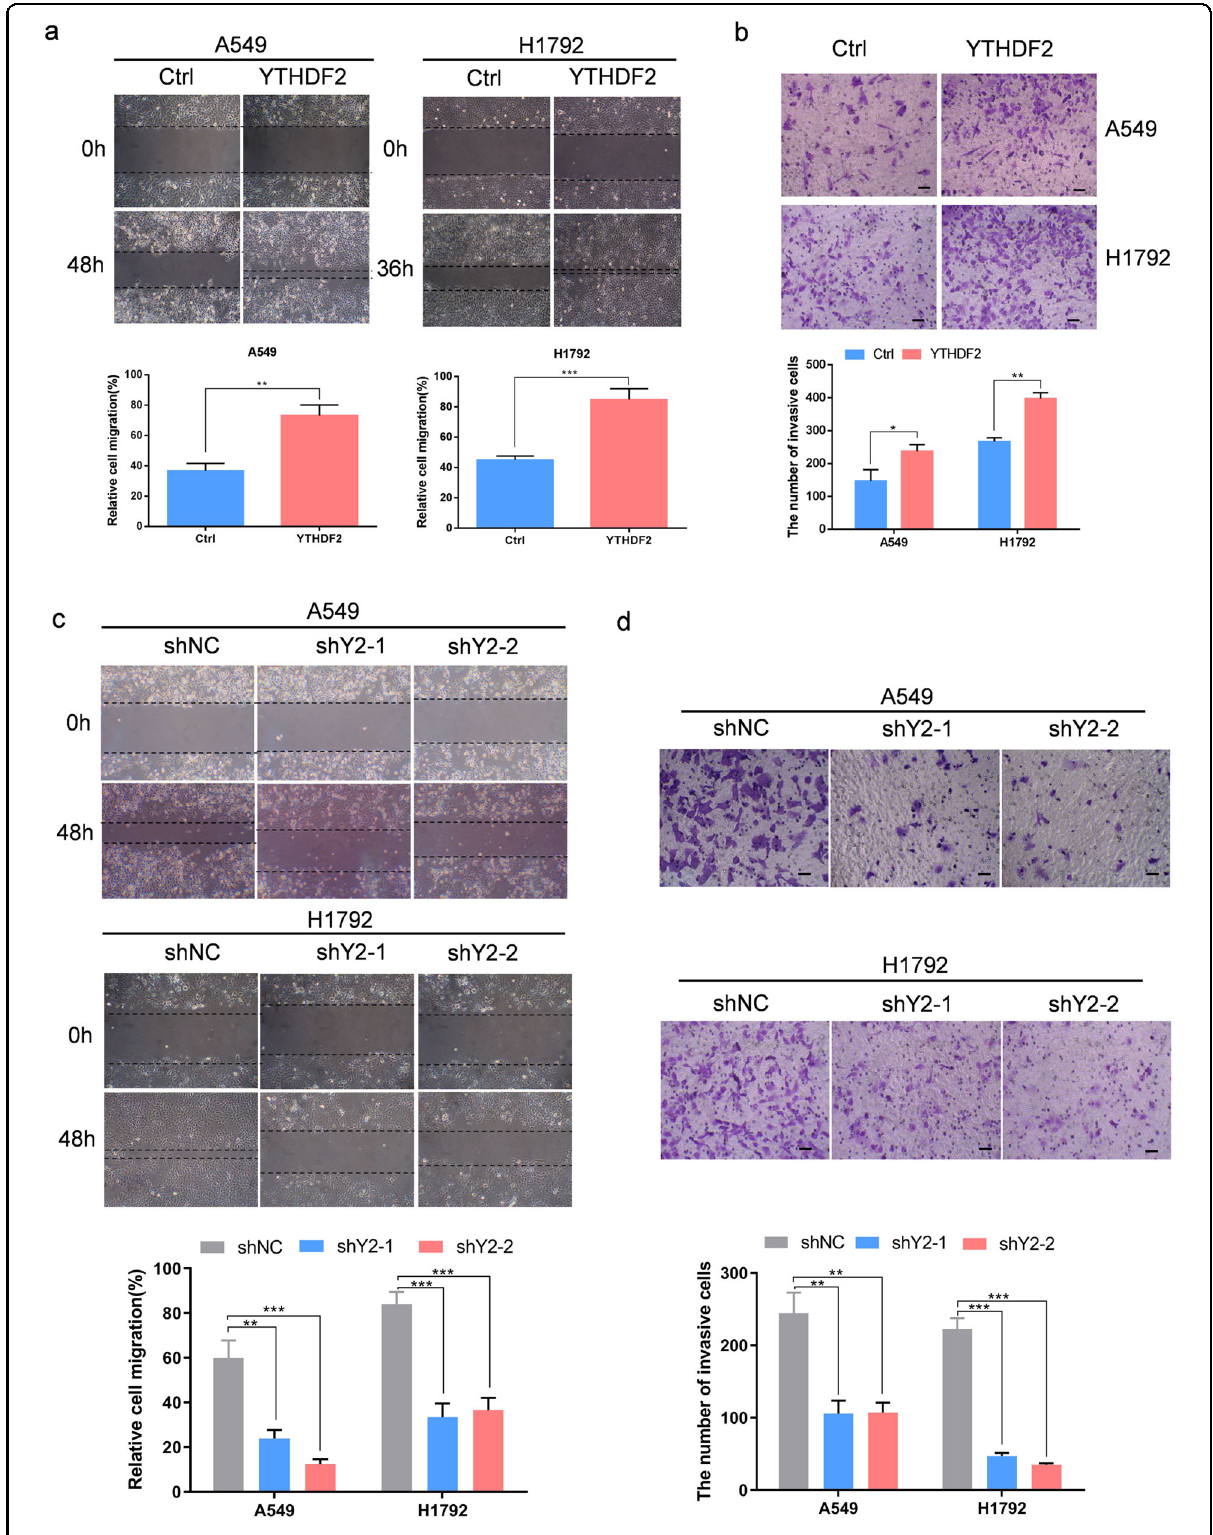
Fig. 3 YTHDF2 regulated the metastatic capacity of LUAD cells. a , b Ectopic overexpression of YTHDF2 signi fi cantly promoted A549 and H1792 cell migration and invasive capabilities as examined by wound healing ( a ) and Transwell invasion ( b ) assays. Data are shown as means ± S.D.; * P < 0.05, ** P < 0.01, and *** P < 0.001 compared with control cells. c , d Silencing of YTHDF2 by shRNA effectively inhibited A549 and H1792 cell migration and invasive capabilities. Data are shown as means ± S.D.; ** P < 0.01 and *** P < 0.001 compared with control